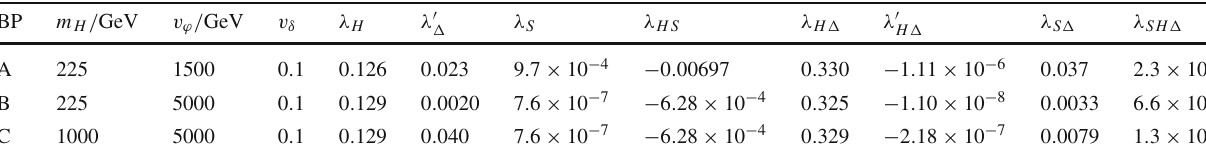
Fig. 4 RGE running of scalar quartic couplings for the benchmark point A in Table 1. The tiny couplings λ S and λ HS (cid:3) that run very little are not